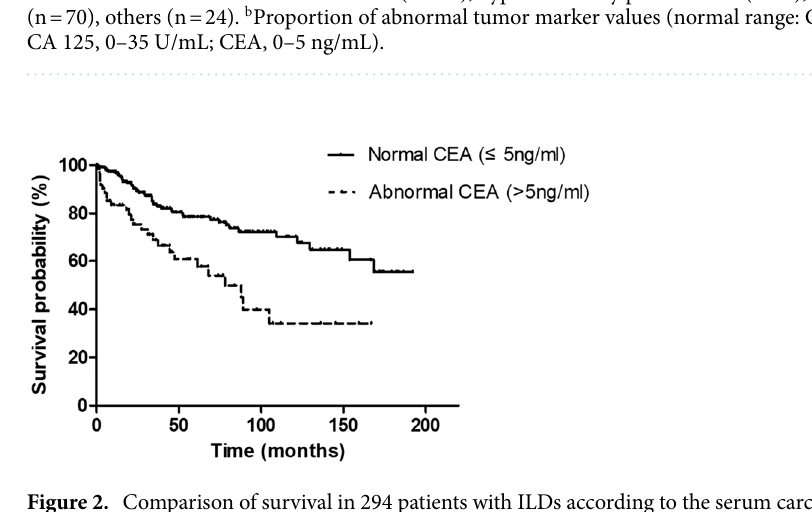
Figure 2. Comparison of survival in 294 patients with ILDs according to the serum carcinoembryonic antigen level. CEA carcinoembryonic